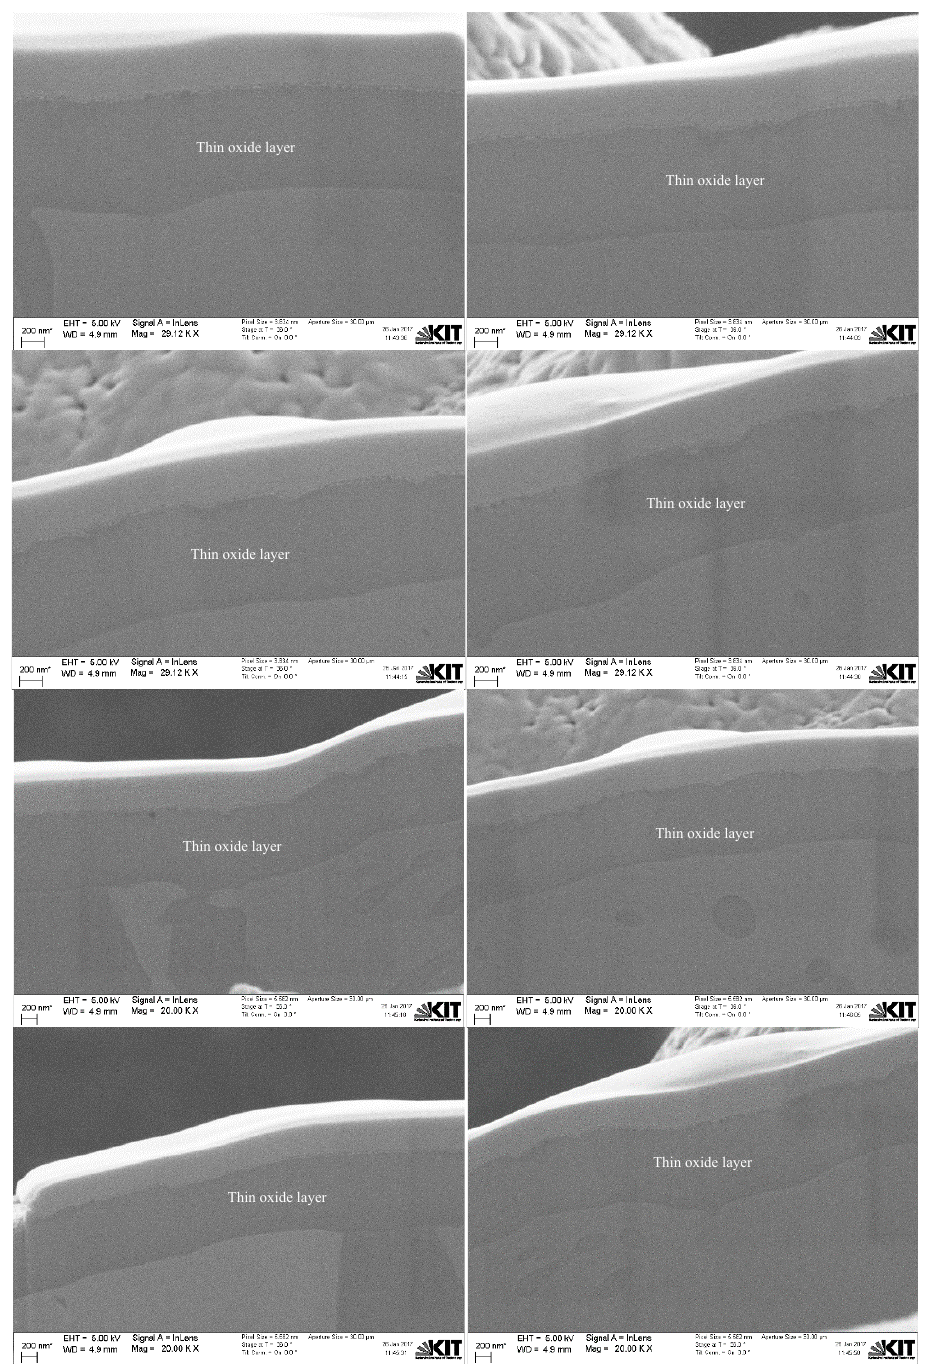
Figure 8. Dual FIB-SEM images of Cu particles with less than 149 µm with InLens detector at 36° stage tilt at various positions.